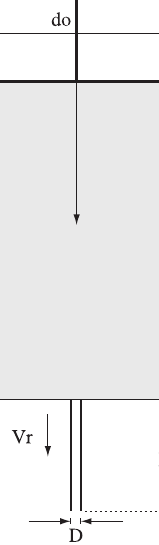
Figure 2. Schematic diagram of the cone and plate rheometer. θ , is the gap angle between cone and plate and r , is the radius of the cone (and plate as